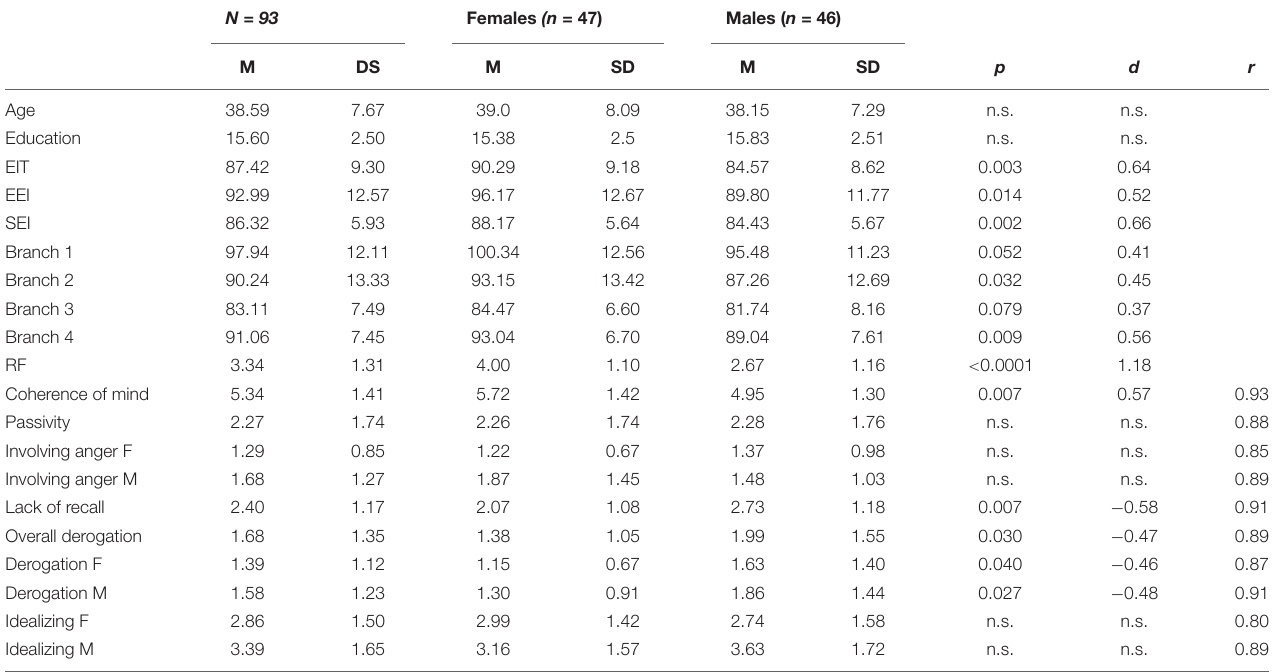
TABLE 1 | Descriptive statistics, comparisons by gender, and inter-rater